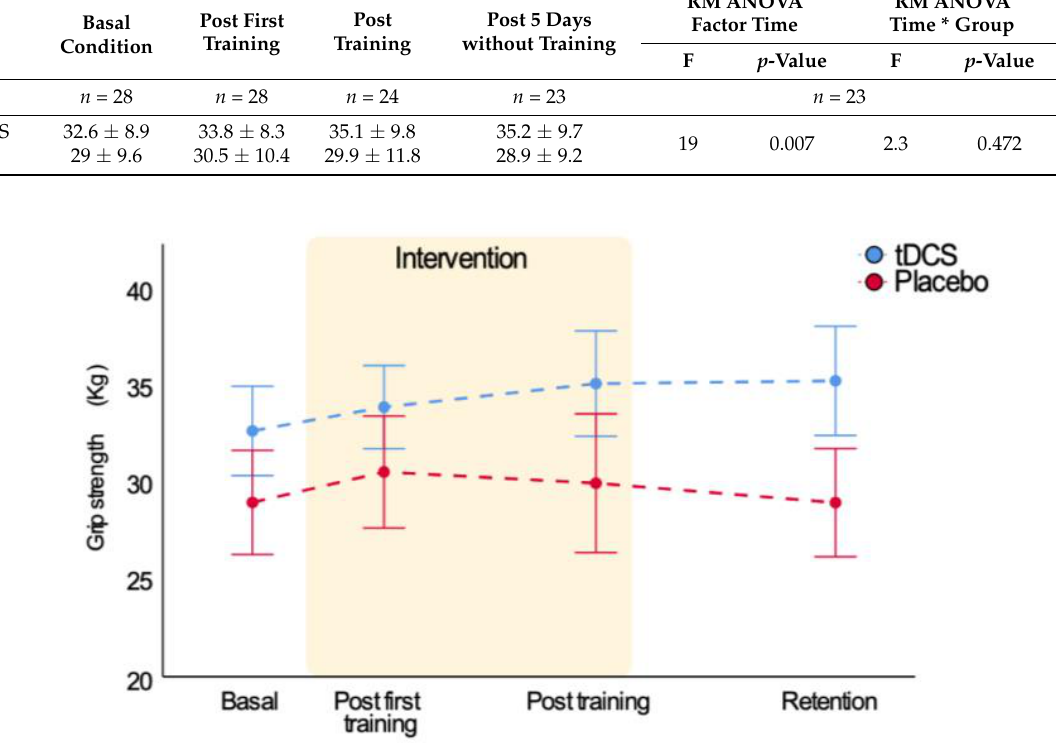
Figure 5. Bi-RP-tDCS effects on grip strength.